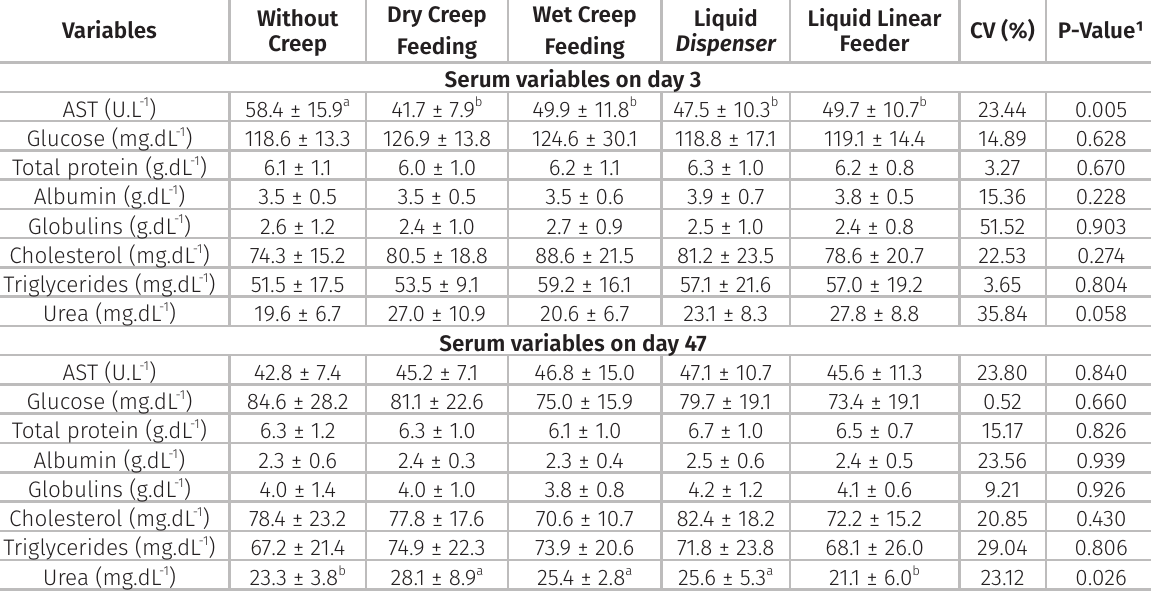
Table V. Serum biochemical of the piglets in a nursery phase of 3 and 47 days under different feed protocols across suckling